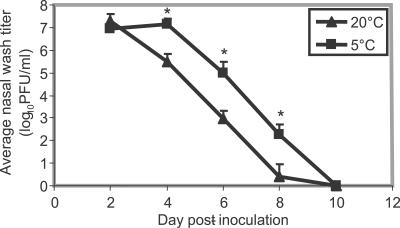
Guinea Pigs Housed at 5 °C Shed Influenza Virus at Higher Titers on Days 4, 6, and 8 p.i. Than Guinea Pigs Housed at 20 °CAverage viral titers in nasal wash samples collected from animals housed at either 5 °C or 20 °C and all RH tested are plotted as function of time post-infection. Error bars indicate standard deviation; * indicates statistically significant difference between titers at 5 °C and 20 °C, with p ≤ 0.005.